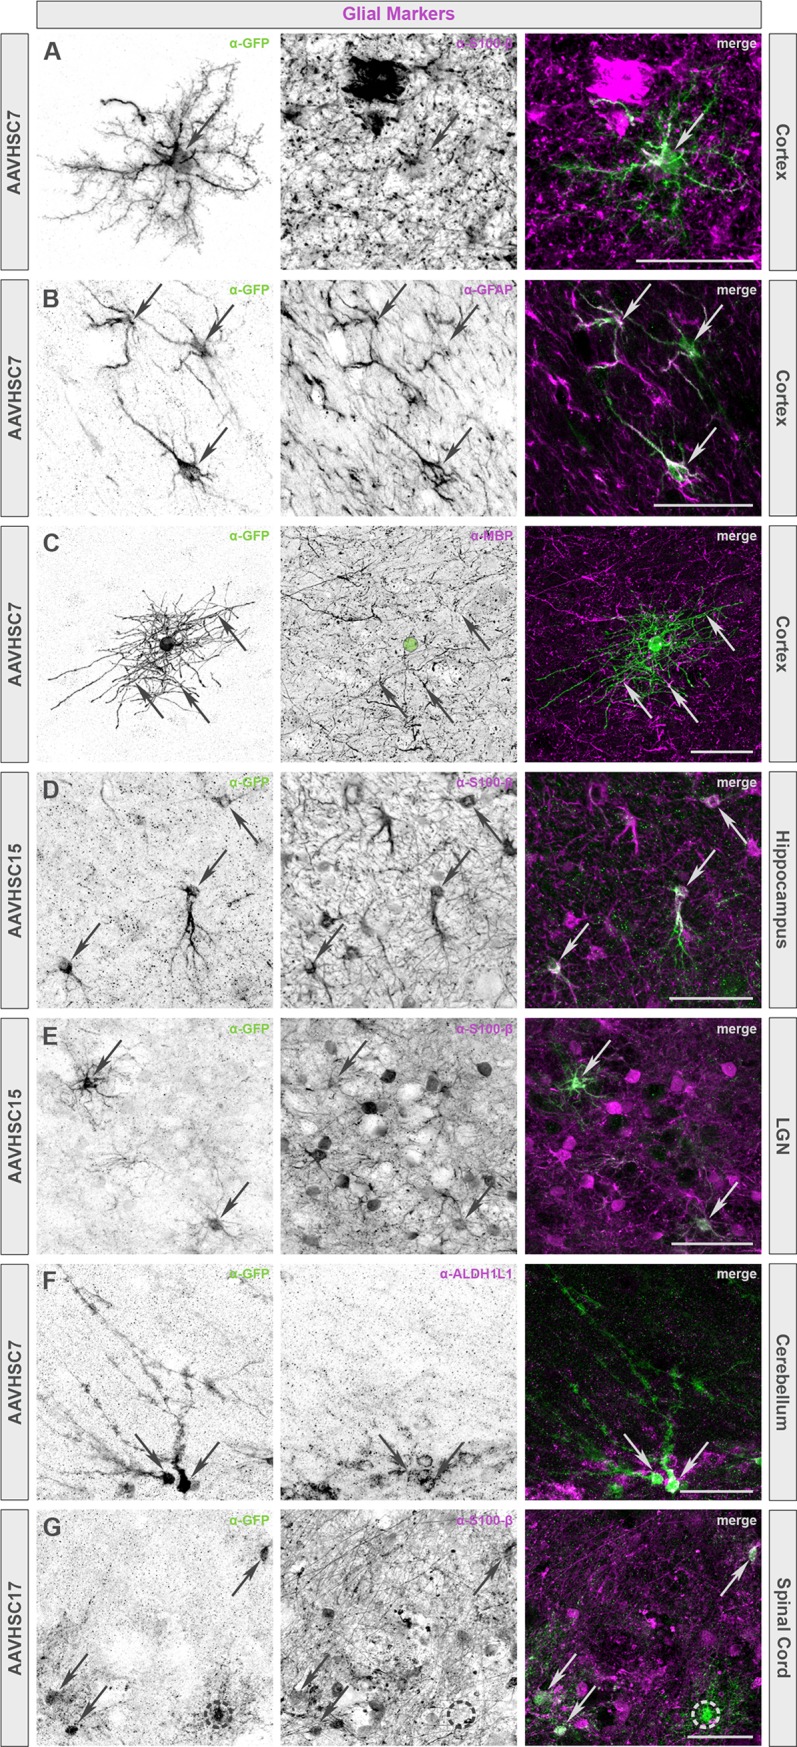
Colocalization of eGFP immunofluorescence with glial markers in multiple brain regions of nonhuman primates treated with an IV dose of scAAVHSC-CBA-eGFP.(A, B, C, F) Animals were dosed with scAAVHSC7-CBA-eGFP. (D, E) Animals were dosed with scAAVHSC15-CBA-eGFP. (G) The animal was dosed with scAAVHSC17-CBA-eGFP. Glial-like profiles of eGFP-positive cells included protoplasmic and fibrous astrocytes (A, B and D-G, respectively) as well as oligodendrocytes (C). The identity of cells with these profiles was confirmed with either myelin basic protein (MBP), a marker exclusively expressed by myelinating glia including oligodendrocytes (C) or astrocyte markers, including S100-β (A, D, E, G), glial fibrillary acidic protein (GFAP) (B), and ALDH1L1 (F). In all panels, arrows indicate colocalization. Green circle in C denotes the location of the oligodendrocyte cell body. Dashed circle in G marks an eGFP-positive cell with a glial-like profile that has no S100-β expression. Scale bars represent 50 μm.